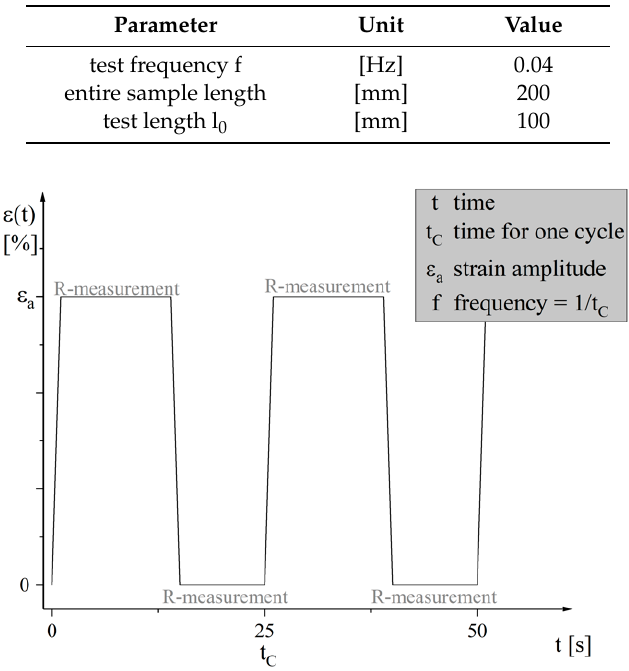
Table 3. Parameters of the cyclic tests.